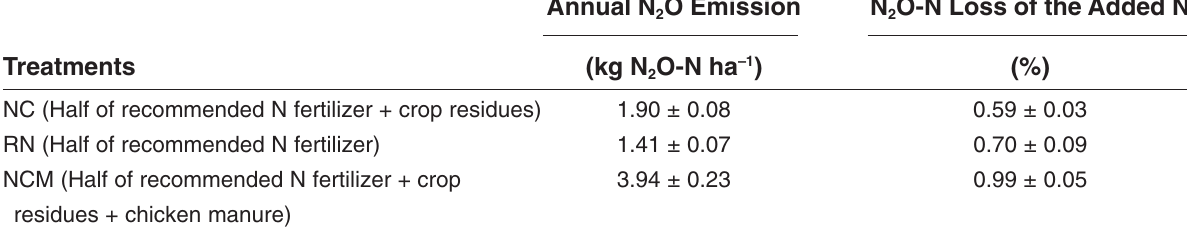
Annual N O Emission and Apparent N O-N Loss 2 2 from the Added N Sources During Maize-Groundnut Crop Rotation Annual N O 2